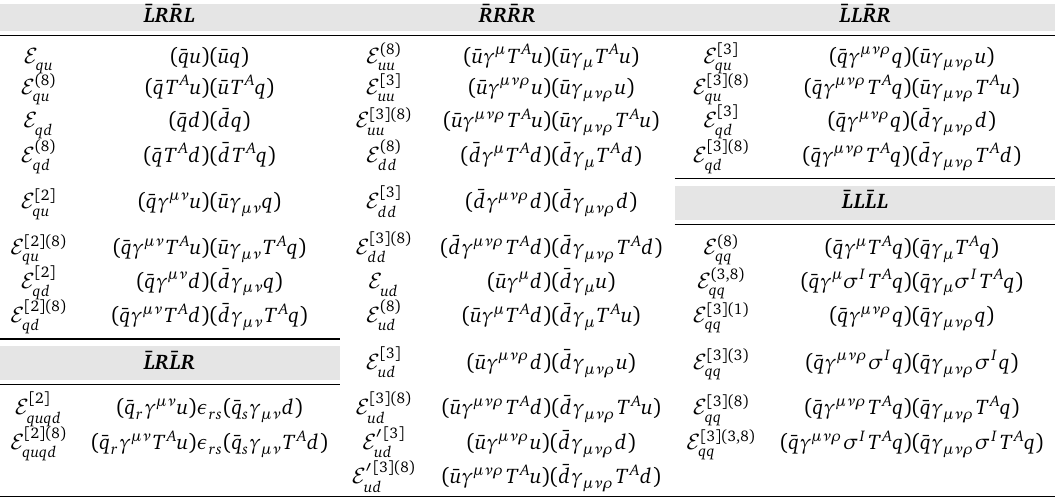
Table 5: Evanescent operators with four fermions involving only quarks.